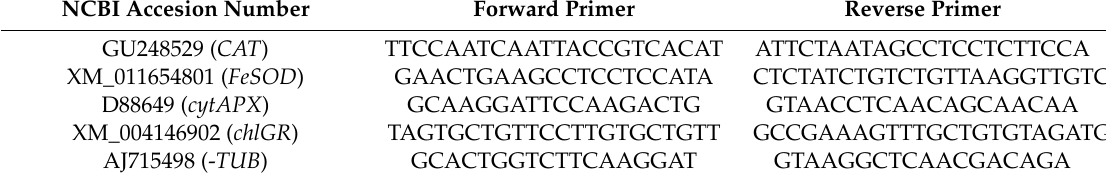
Table A3. Primer sequences for the target and reference genes.